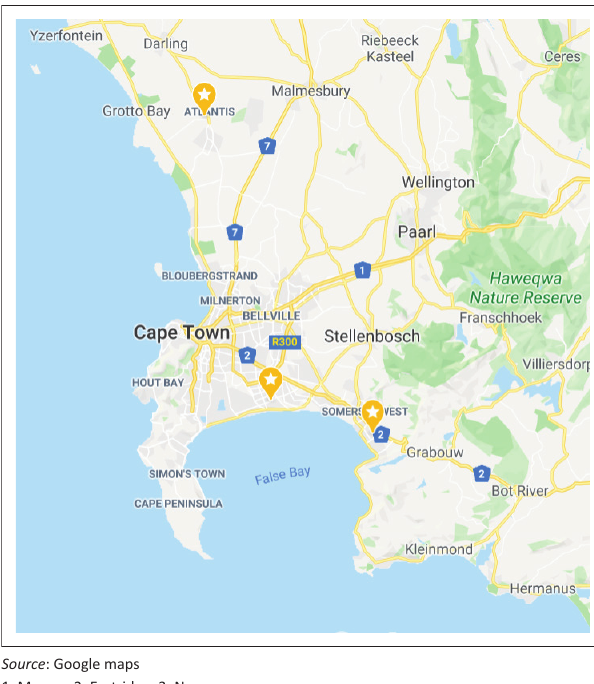
FIGURE 1: Location of learning sites in Cape Town.